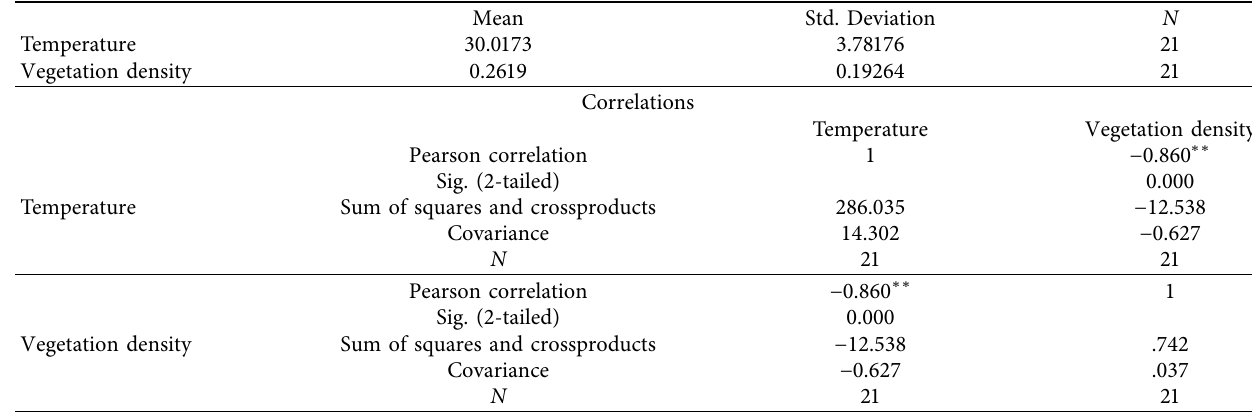
Table 8: Te correlation between surface temperature and vegetation density in Banjarmasin city in 2015.